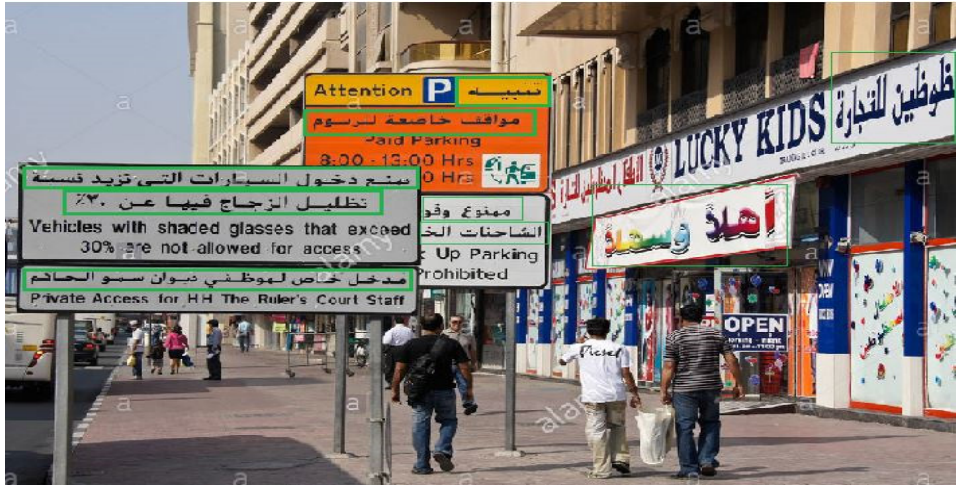
Figure 2. Arabic natural scene text dataset.